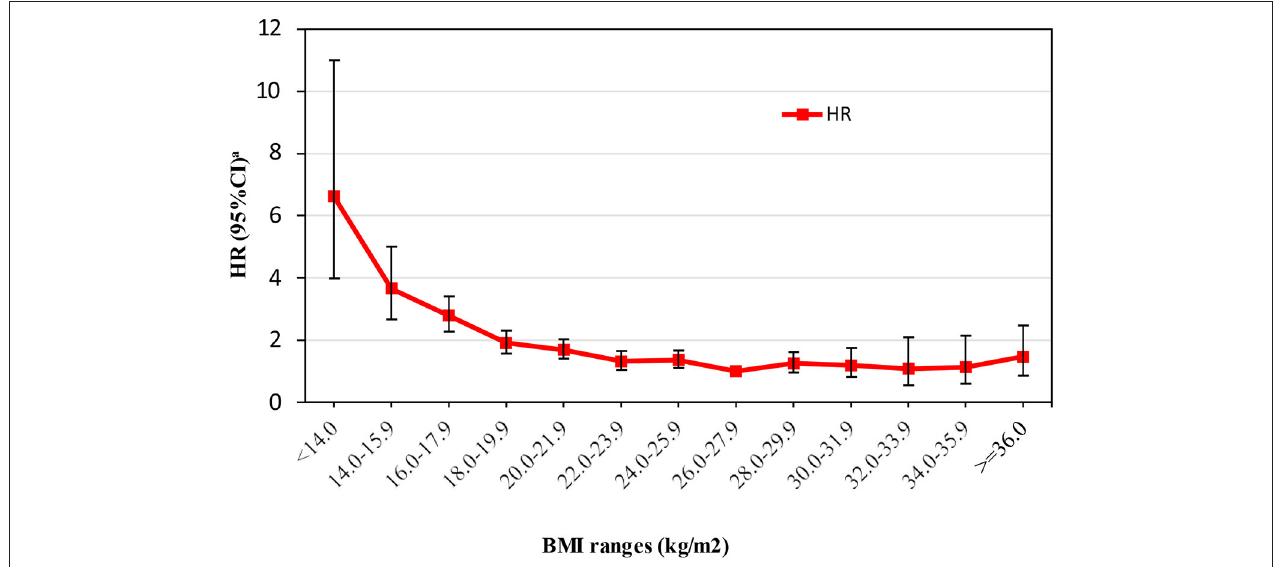
FIGURE 3 | Association between the ranges of body mass index (BMI) and all-cause mortality after adjustment for potentially confounding factors. a HR, hazard ratio; CI, confidence